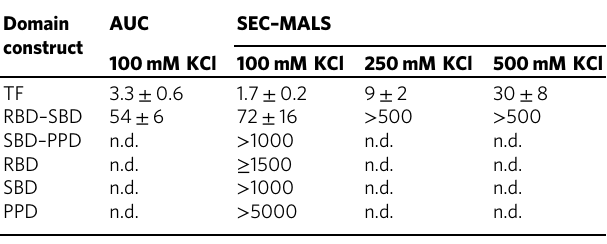
Table 1 Dimer dissociation constants K D ( μ M) of TF